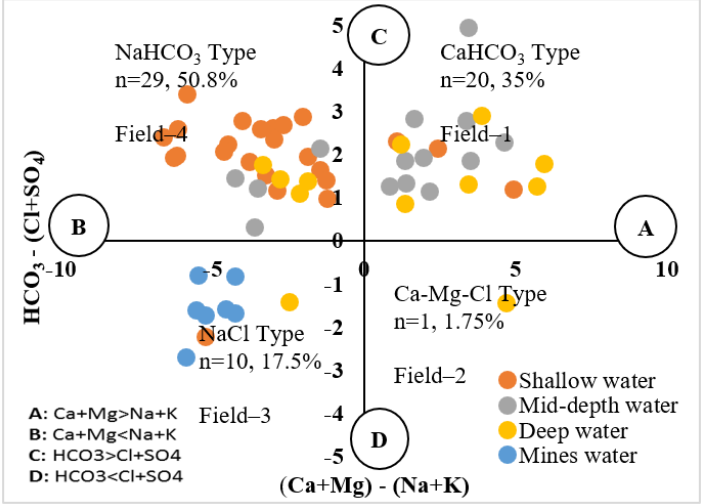
Figure 4. Chadha scatter diagram that indicates the composition of groundwater type in the Adenzai region. Field-1 indicates Ca-HCO 3 -type water compiling weathering and a recharge mechanism, and Field-2 shows that Ca-MgCl groundwater determines the ionic reverse exchange. Field-3 reveals evap- oration forming the NaCl type, and Field-4 defines NaHCO 3 -type elaborate ion-exchange